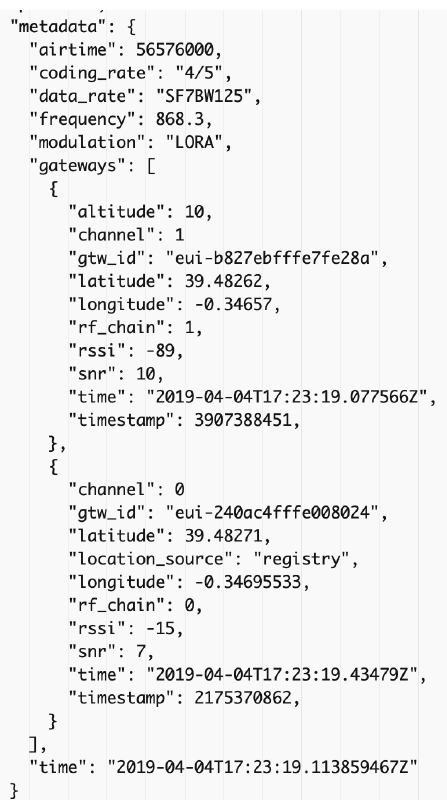
Figure 3. The metadata content provided by the networks